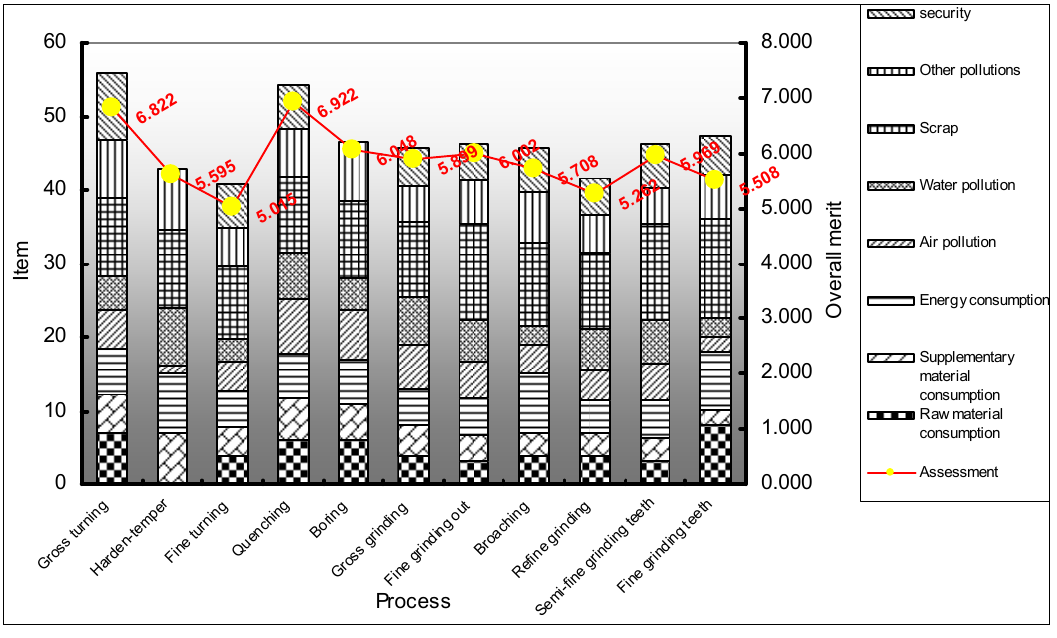
Figure 6. Cross-longitudinal comparison of each recourse and environment in the gear manufacturing